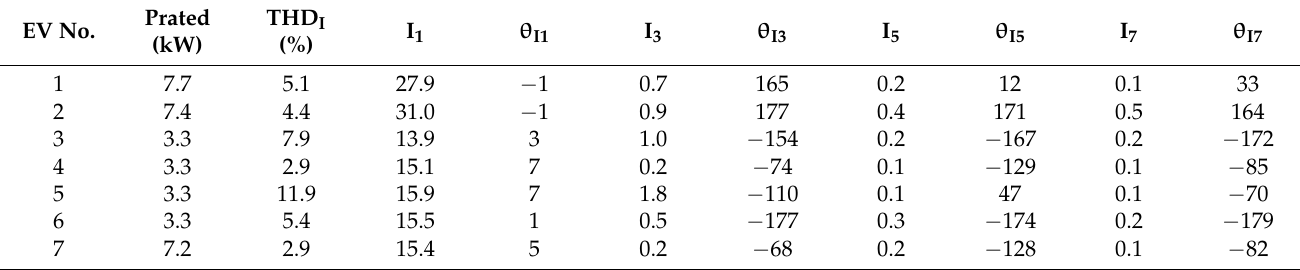
Table 3. Measured harmonics for individual